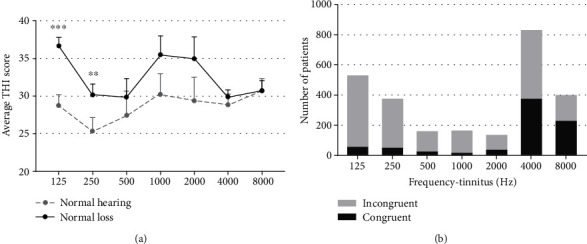
(a) Comparison of the THI scores of tinnitus patients with normal and abnormal hearing. ∗∗p < 0.01 and ∗∗∗p < 0.001 for differences between the labeled group at each frequency versus the normal hearing group. Error bars represent the standard errors of the means. (b) The number of patients with or without coincidence (tinnitus pitch vs. hearing threshold showed the deepness of hearing loss) in various frequency tinnitus subgroups with hearing loss.